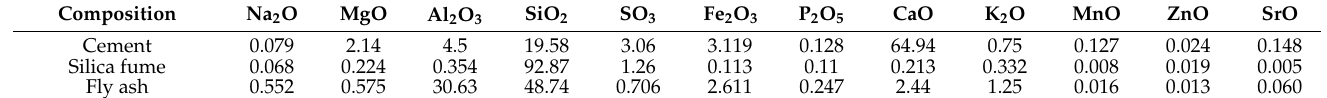
Table 4. Chemical compositions of cementitious materials.